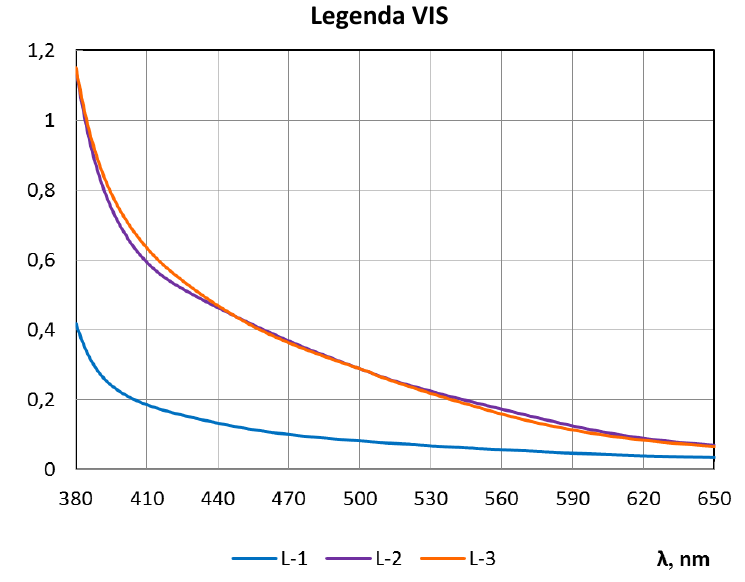
Figure 3. The absorption spectra of Legenda wine samples in the visible region, (undiluted wines, cuvettes path length 1